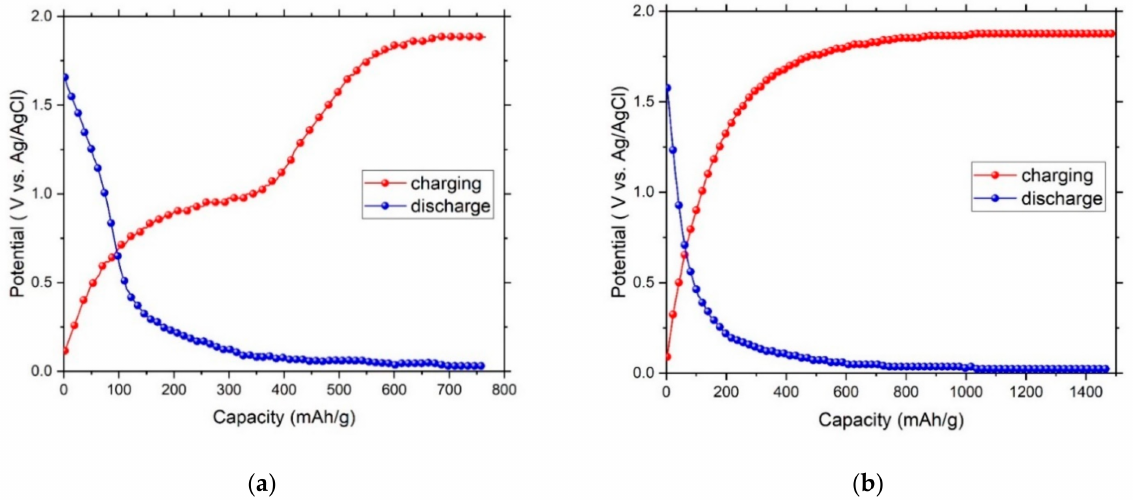
Figure 5. The charge–discharge curves in 3M KOH electrolyte for ( a ) G/f-MWCNT electrode; ( b ) G/ f -MWCNT@PdMg electrode.